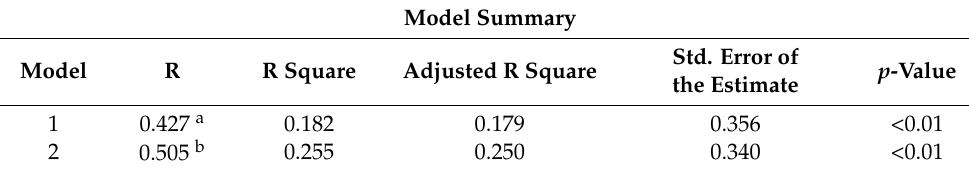
Table 6. A multivariable model that predicts the need for antibiotic